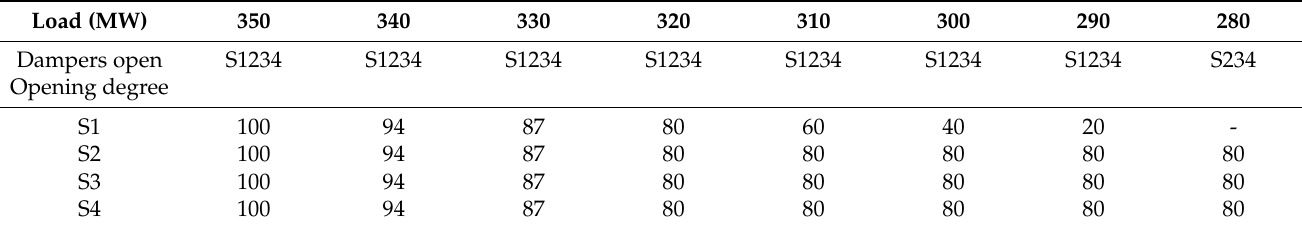
Table 10. SOFA dampers opening status and opening degree